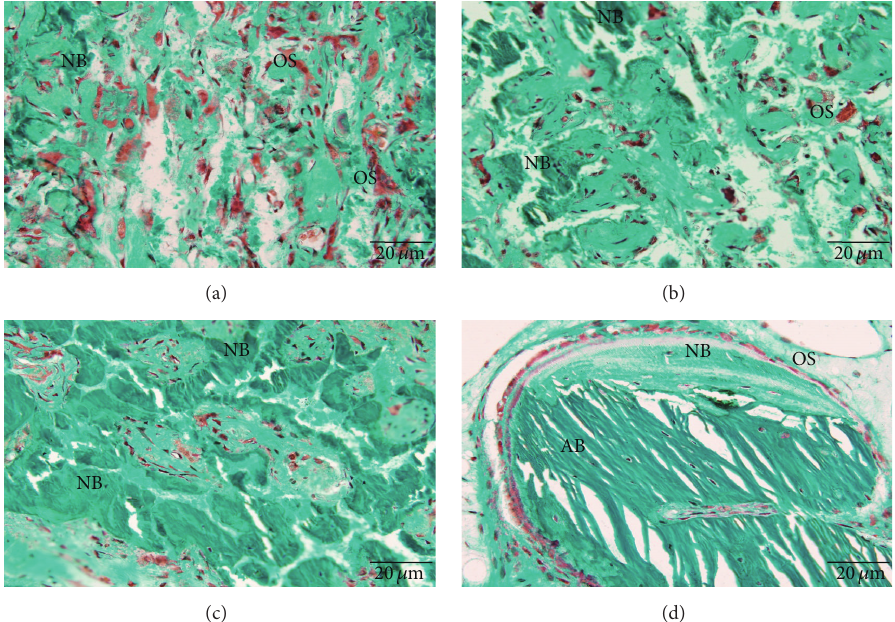
Figure 6: Bone regeneration in a rabbit critical-size mandibular defect model stained with Goldner’s trichrome. (a) The defects in the nHAC/PLA group were filled with abundant red-stained osteoid tissue and some green-stained newly formed bone. (b) The defects in the nHAC/PLA + aBMSCs group were filled with more newly formed trabeculae. (c) The defects in the nHAC/PLA + preinduced aBMSCs group were filled with a large amount of mature thickened bone. (d) The AB group exhibited areas of newly formed bone, osteoid tissue, osteoblastic seams, and residual bone graft. Magnification: × 400. NB: new mature bone; AB: autogenous bone; OS: osteoid